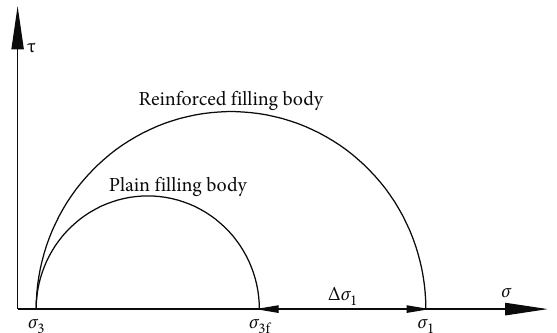
Figure 10: Variation of normal stress of backfill under the same side stress condition.